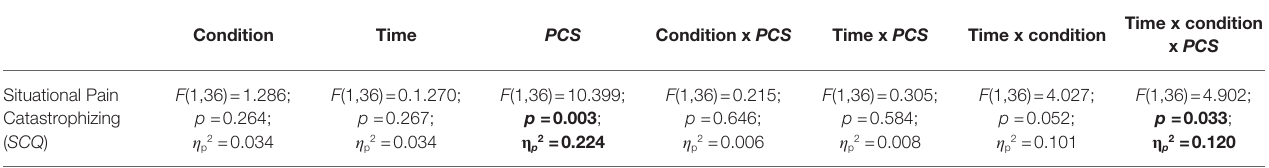
TABLE 2 | F -Tests, value of p and effect sizes of the analysis of covariance (ANCOVA) with the factors condition (between-subjects, levels: BPS and TD), time (within- subject, levels: pre and post) and the covariate dispositional pain catastrophizing (Pain Catastrophizing Scale: PCS ) for the dependent variable situational pain